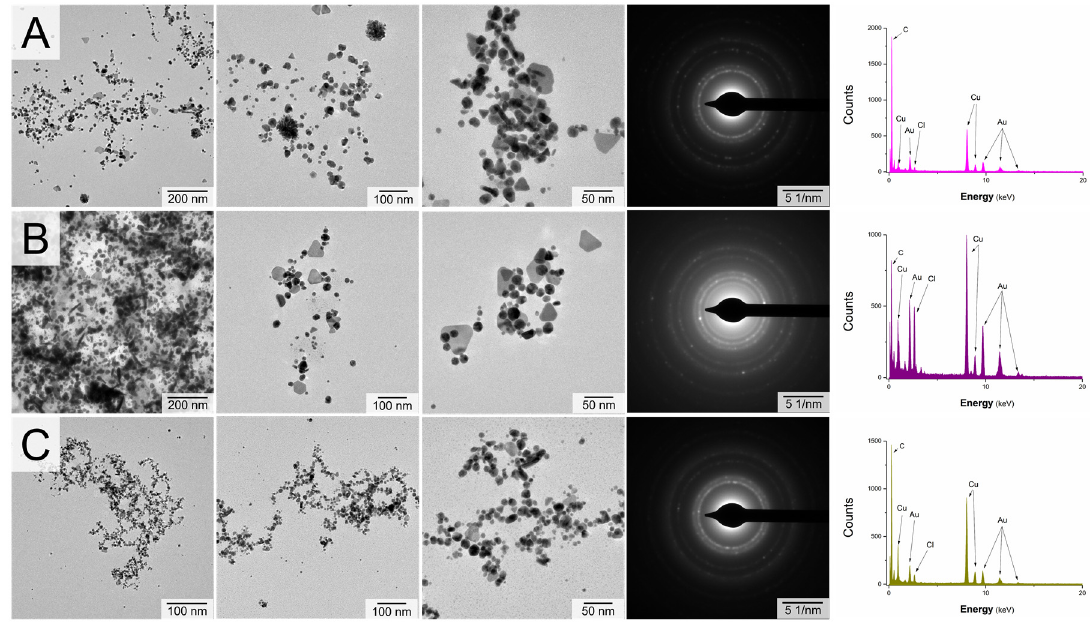
Figure 4. TEM photomicrographs, SAED patterns and EDX spectra of AuNPs obtained using ( A ) untreated; ( B ) FLA-dc-APGD-activated; or (C) FLC-dc-APGD-activated aqueous P. ginseng root extracts. The concentration of Au (III) ions used for the synthesis of biogenic AuNPs was 500 mg L − 1